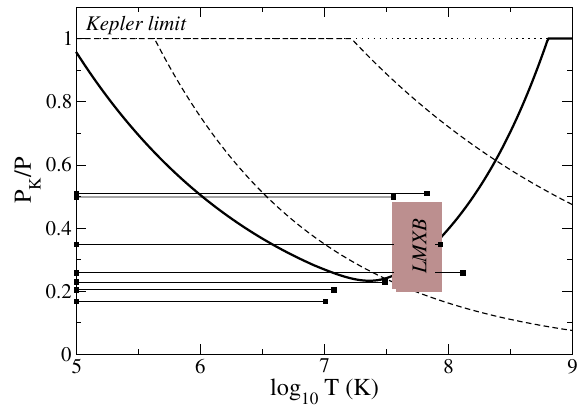
Fig. 17 The r -mode instability window for a strange star of M = 1 . 4 M (cid:3) and R =10 km (solid line). Dashed curves show the corresponding instability windows for normal npe fluid and neutron stars with a crust. The instability window is compared to (i) the inferred spin-periods for accreting stars in LMBXs [shaded box], and (ii) the fastest known millisecond pulsars (for which observational upper limits on the temperature are available) [horizontal lines]. (Image reproduced with permission from Andersson et al. 2002, copyright by